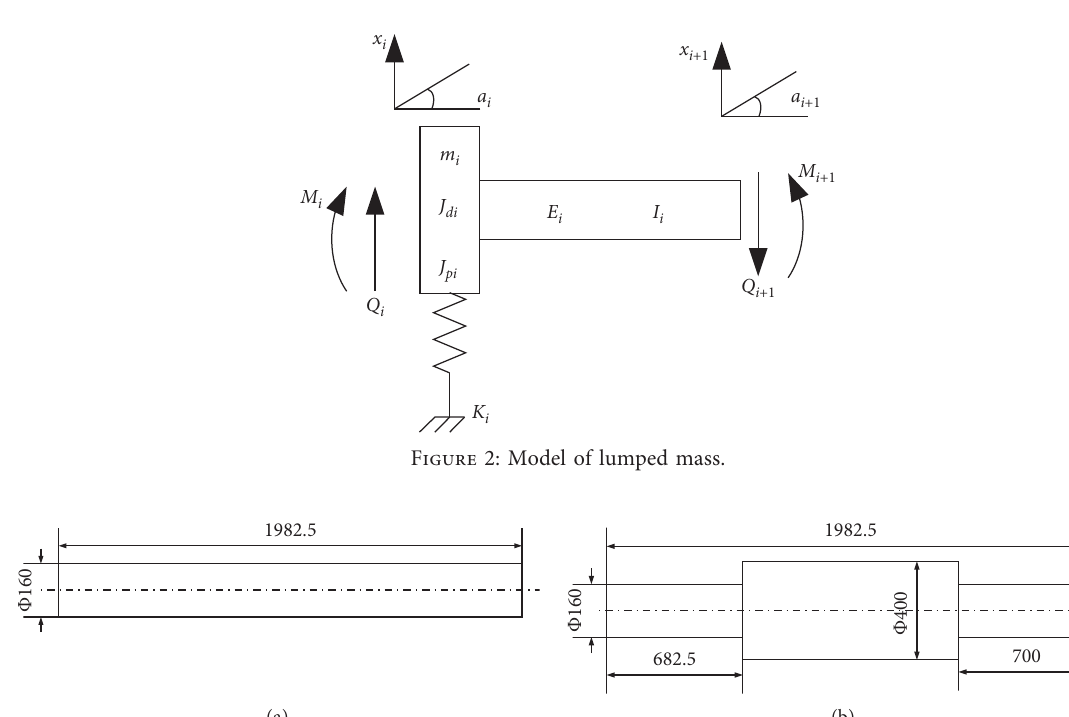
Figure 3: The simple models of rotor. (a) The equidiameter shaft and (b) the stepped